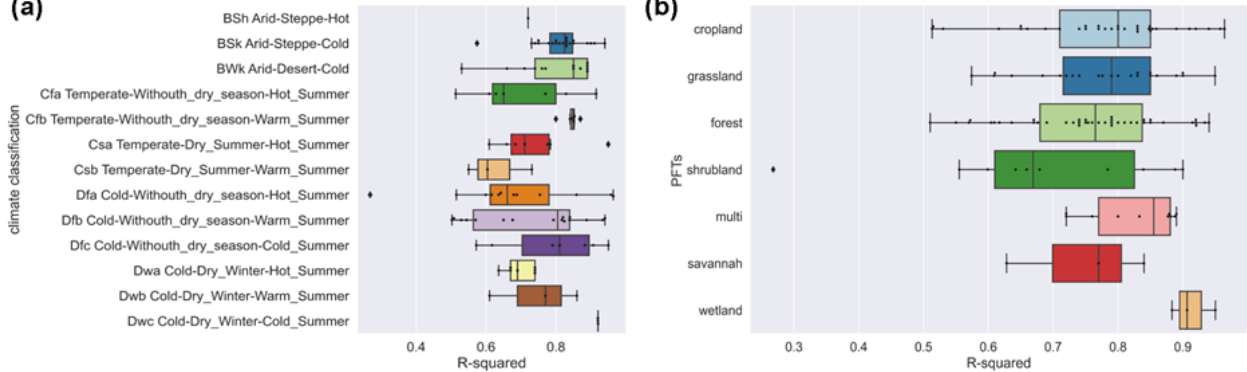
Figure 4. Differences in model accuracy ( R -squared) of (a) various climate zones (classified by Köppen climate classification) across studies and (b) PFTs. BSh – hot semi-arid (steppe) climate. BSk – cold semi-arid (steppe) climate. BWk – cold desert climate. Cfa